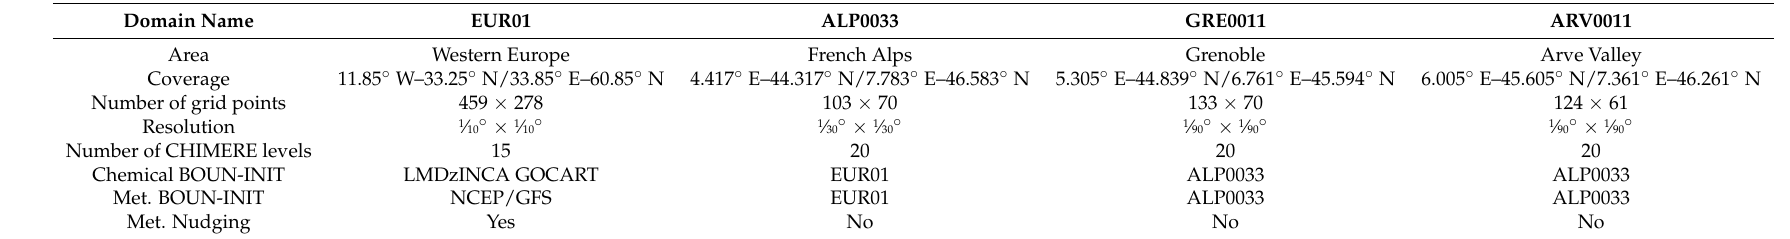
Table 2. Domain specifications (BOUN: Boundary conditions, INIT: